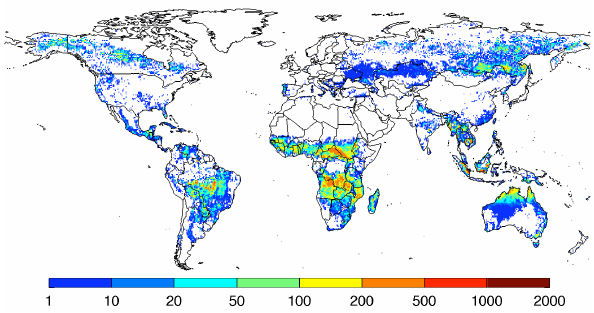
Fig. 11. Mean annual fire carbon emissions (g C m -2 year -1 ), averaged over 1997-2009. This quantity is the product of the fuel consumption (e.g., Fig. 6) and the burned area within the grid cell, divided by the total area of the grid cell.